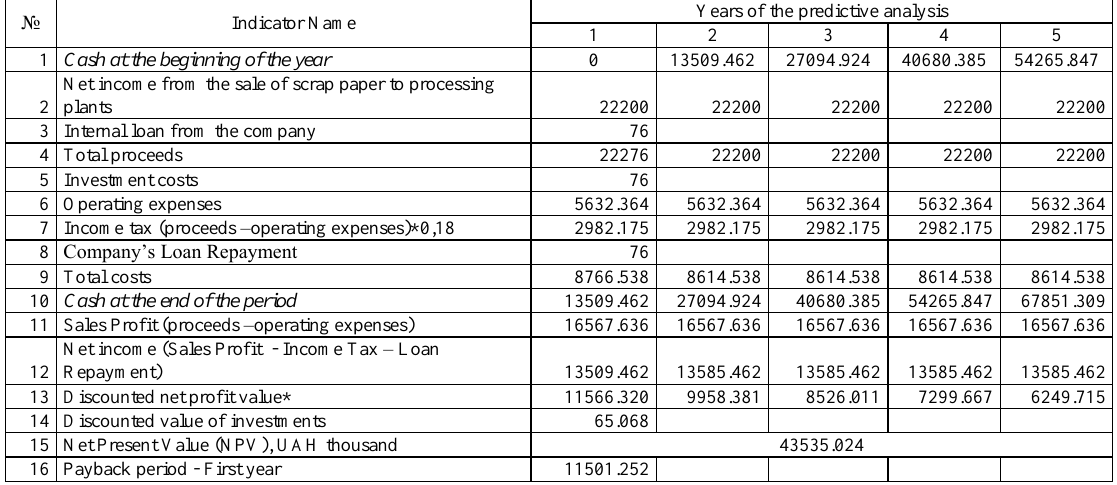
Table 5. Cash Flow Plan-Balance and Calculation of the net present value and payback period from the implementation of the proposed measures, UAH